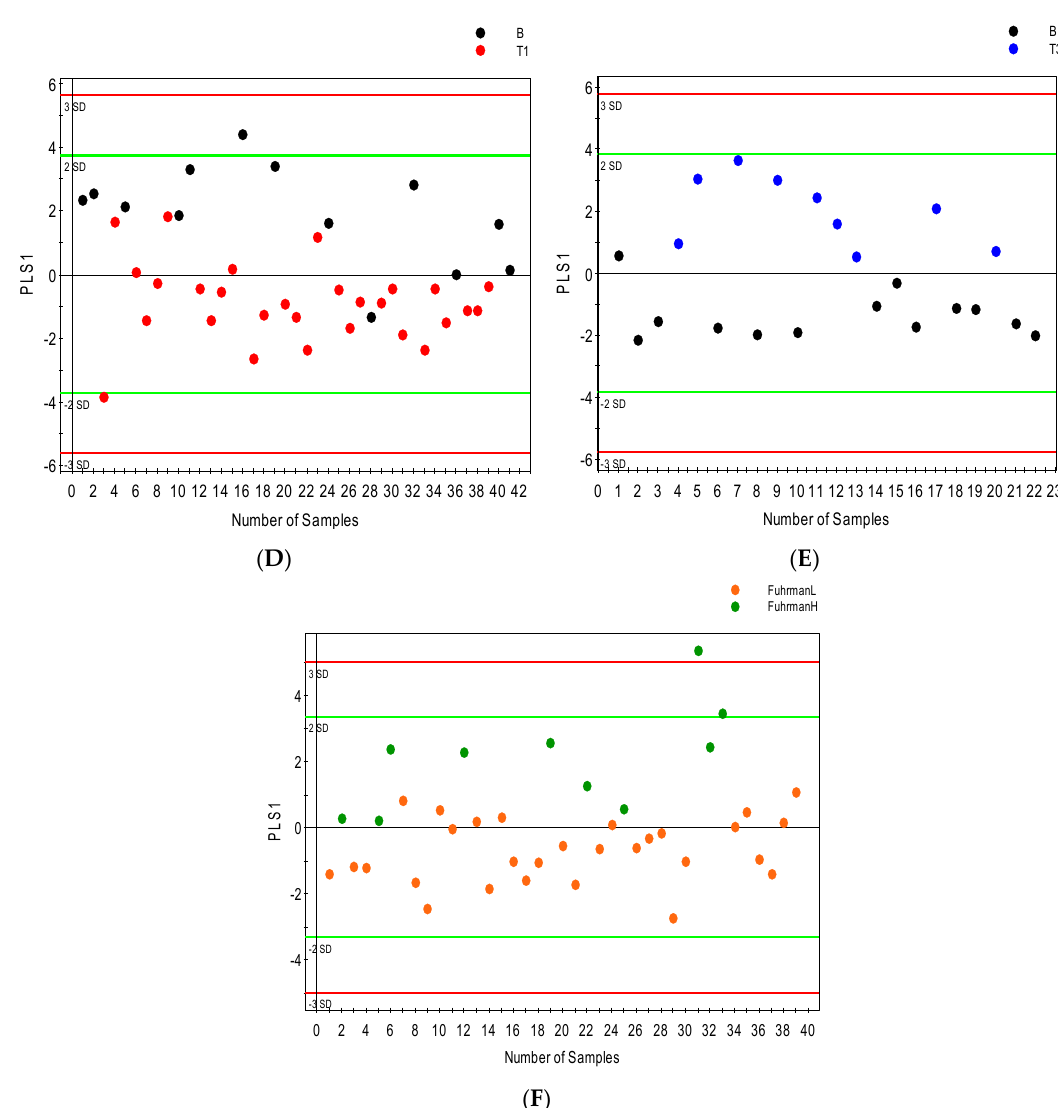
Figure 2. NMR orthogonal partial least squares discriminant analysis (OPLS-DA) models distinguishing between benign and cancer cases. OPLS-DA score scatter plots showing separation in the serum metabolic profile of ( A ) benign versus stage 1 cancer cases; ( B ) benign versus stage 3 cancer cases and ( C ) low grade (FuhrmanL–stages 1 and 2) versus High grade (FuhrmanH–stages 3 and 4) cancer; separation in urine metabolic profile ( D ) benign versus stage 1 cancer cases ( E ); benign versus stage 3 cancer cases ( F ); and low grade (FuhrmanL–stages 1 and 2) versus High grade (FuhrmanH–stages 3 and 4) cancer along their orthogonal partial least squares (OPLS1) and partial least squares components (PLS1).